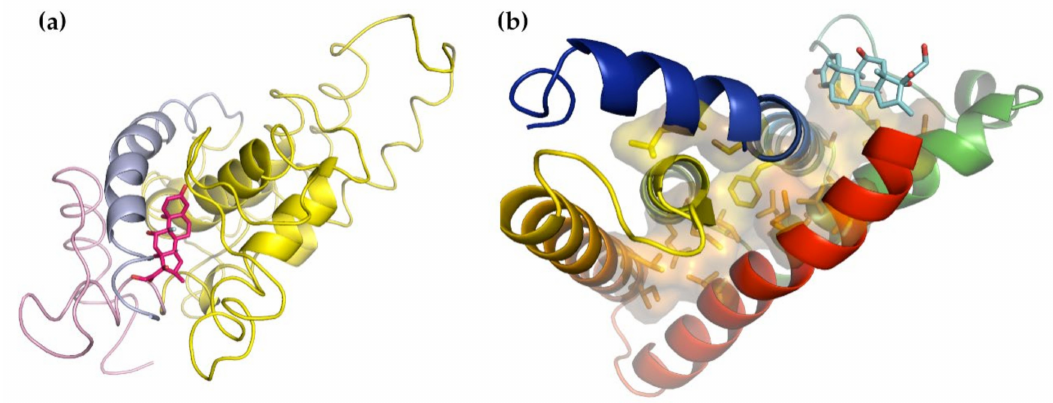
Figure 9. Fragments of the GCR-LBD. ( a ) A distortion of the first truncation (Figure 7b) following the 10 non-zero modes with the highest collectivity and an RMSD target of 2.0 Å. It can be seen that one effect of removing NT1 was the unraveling of the N-terminal part of NT2, which contained a large number of residues that were involved in binding the hormone. ( b ) The three-way link between α -helices 8, 7, and 5, forming the last major sticking point between two different unfolding